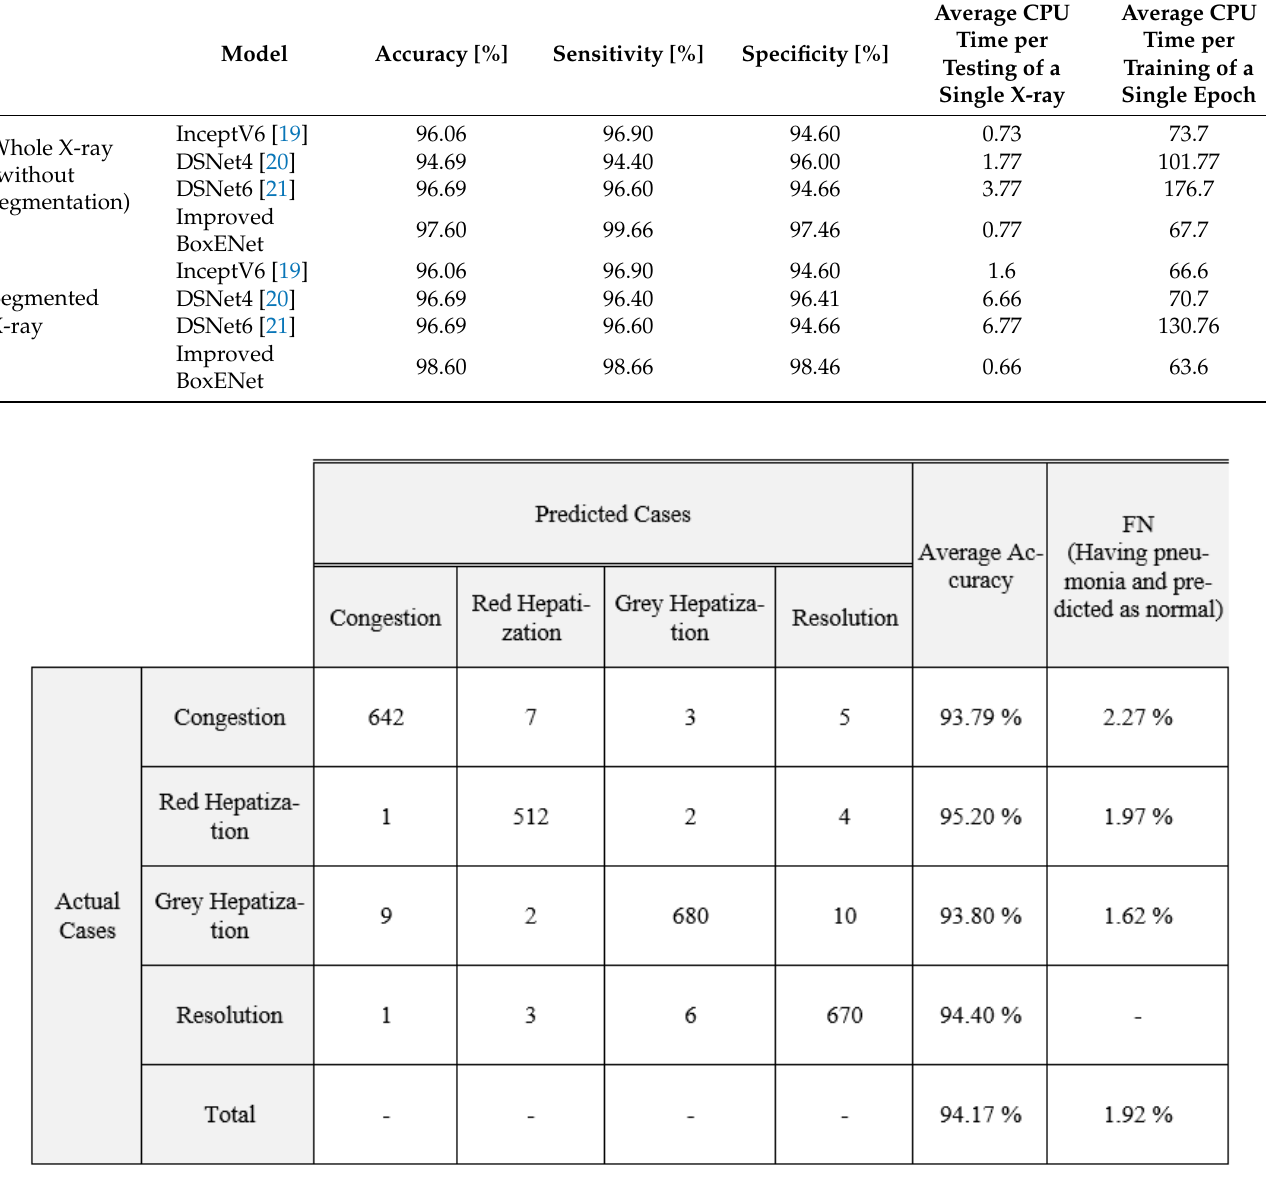
Figure 7. Confusion matrix for multiclassification for the improved BoxENet model with segmented X-ray.